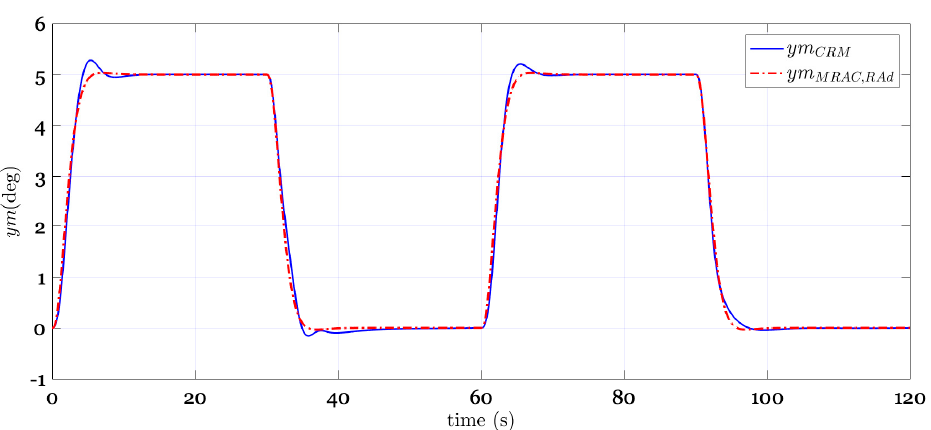
Figure 15. Reference model from CRM and robust adaptive controller with 10 λ θ ρ ρ= = .